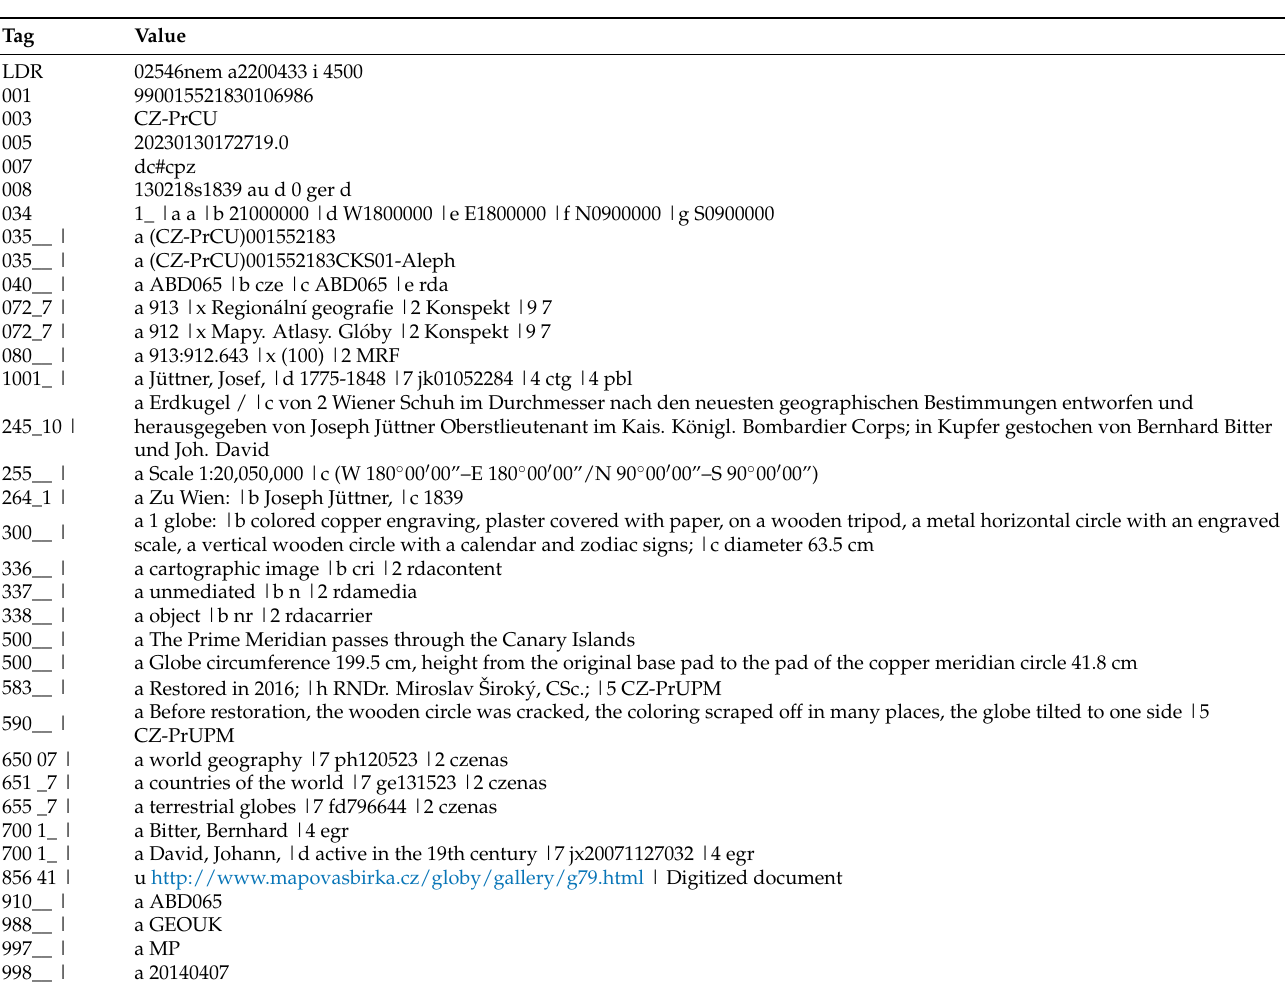
Table A1. Example of a globe metadata record in MARC21 format. Source: Map Collection of the Faculty of Science, Charles